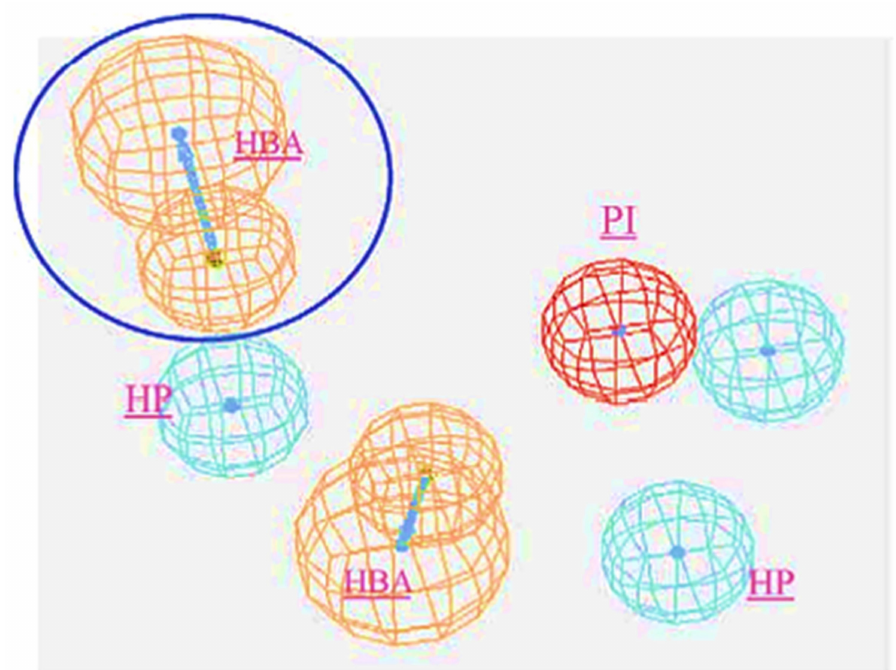
Figure 9. Statistically best-feature hypothesis (HBA: Hydrogen Bond Acceptor; HP: Hydrophopic; PI: Positive Ionizable). The best fit with HBA interactions is highlighted with circle. Reprinted with permission from Ref. [107]. Copyright 2004, Elsvier.